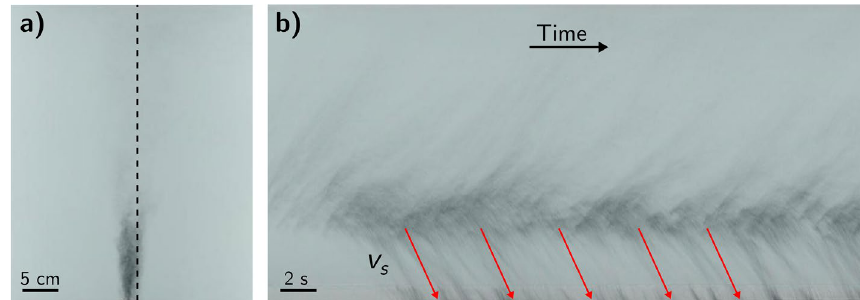
Figure 7. Images from experiment 1 used to measure fall speed of particles. ( a ) Snapshot of experiment 20 s after start of injection. Black dashed-line indicates location of vertical time-series. ( b ) Time-series taken at the edge of particle laden zone showing descending pulses of particles. The red lines indicate the stokes settling speed, v s , of the